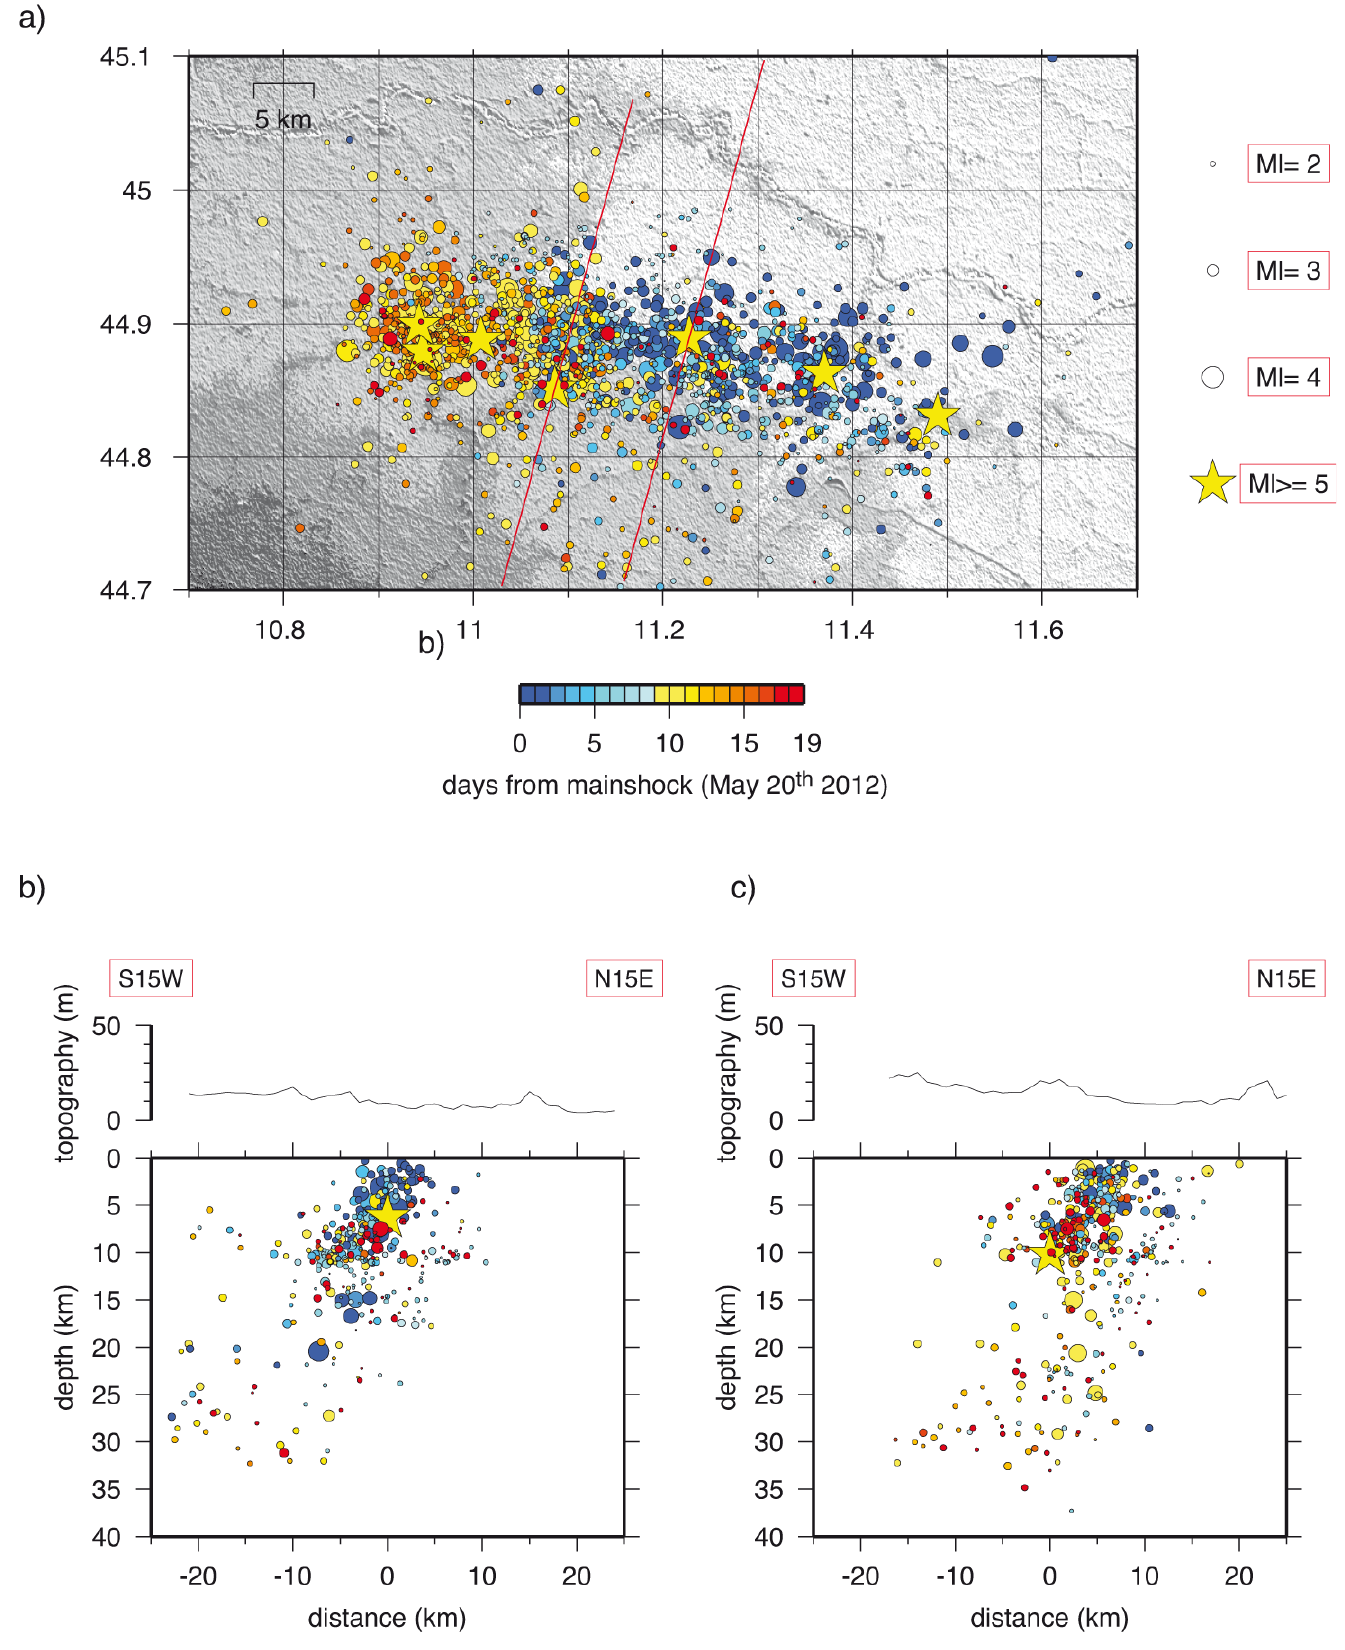
Figure 1. (a) Map of the seismicity for the period May 20 to June 21, 2012, with the color code indicating the time after the main event. Red lines, traces of the vertical sections shown in the bottom of the figure. (b) Vertical section passing through the hypocenter of the May 29, 2012, mainshock, which shows an activated fault system that is clearly dipping to the South. (c) Vertical section across the May 20, 2012, hypocenter shows a relatively complicated activated fault system. The lines above the panels show the surface topography with a ×200 vertical